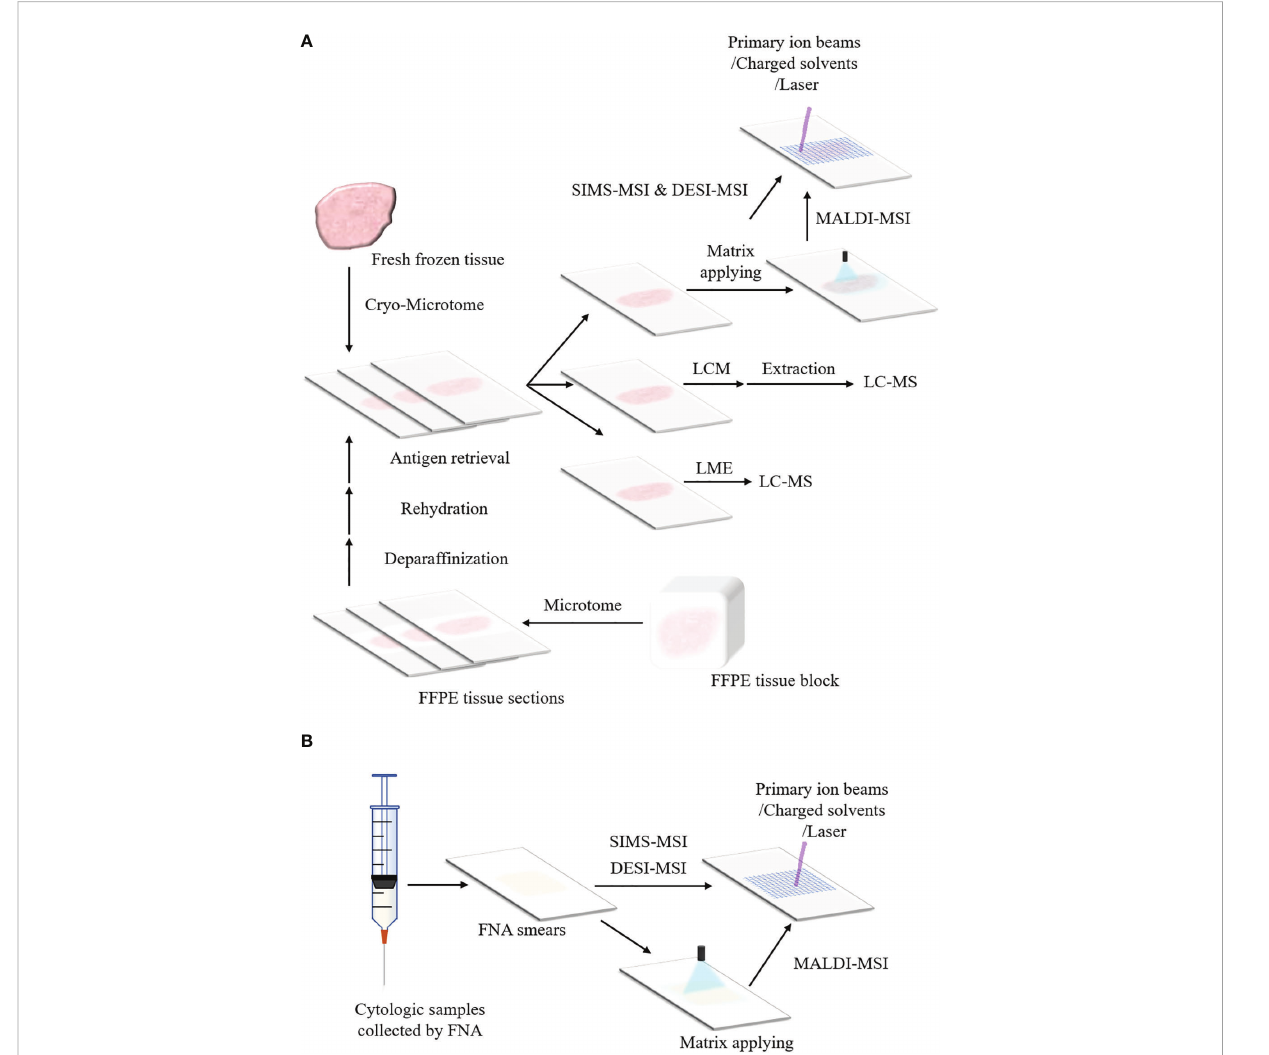
FIGURE 2 Schemes of sample preparation for MSI and microproteomics. (A) Preparation protocols of fresh frozen tissues and FFPE tissue blocks for MSI and LMD or LMJ guided microproteomics. The fresh frozen tissue is sliced into sections by cryo-microtome and the tissue sections are placed on ITO slides or non-conductive slides. Then the tissue sections can be processed with MSI (For MALDI-MSI, matrix applying before data acquisition is necessary). The tissue section can also be processed with LMD or LMJ. For LMD, the region of interest within the tissue section is cut off and extracted, followed by LC-MS. For LMJ, the extracts obtained from the target region within the tissue surface can be directly analyzed by LC-MS. After data acquisition, data analysis is performed. For the FFPE tissue block, it is sliced into tissue sections by microtome. These FFPE tissue sections can be analyzed by MSI or LC-MS until they are treated with deparaf fi nization, rehydration and antigen retrieval. (B) Preparation protocols of cytologic samples for MSI. The cytologic samples are collected by FNA. The cytologic samples are smeared onto the ITO slides or non-conductive slides for the analysis of